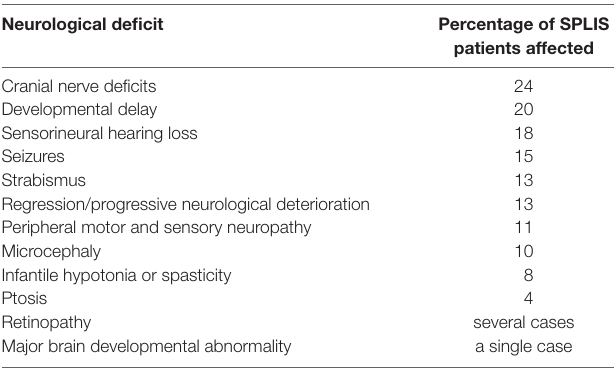
TABLE 1 | Neurological deficits in SPLIS patients.* Neurological deficit Percentage of SPLIS